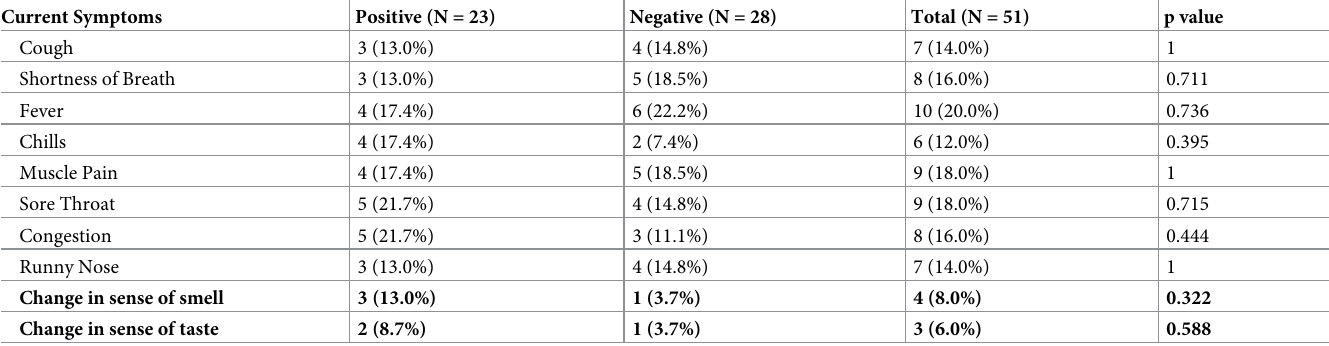
Table 2. Standard COVID screening questionnaire from our institution: In the past 14 days have you experienced any of the following? Current Symptoms Cough